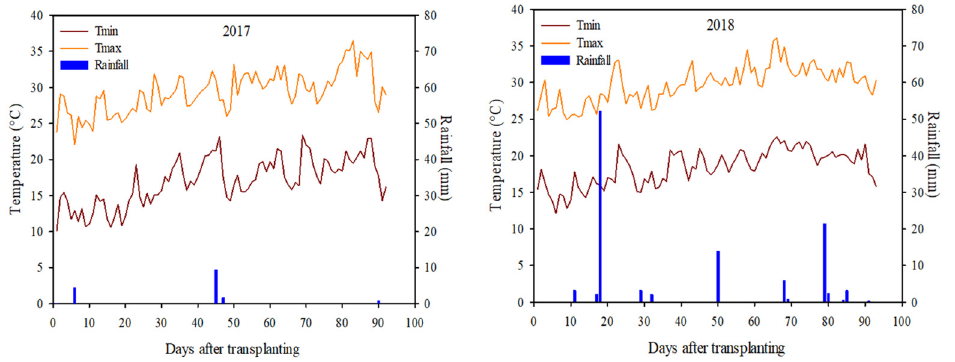
Figure 2. Daily maximum and minimum air temperature and rainfall during the 2017 and 2018 field trials of processing tomato.